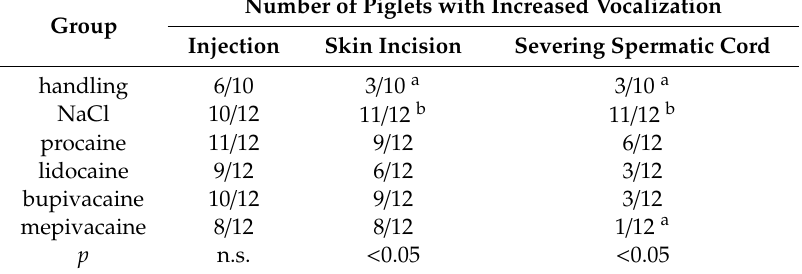
Table 3. Number of piglets with increased vocalization / number of piglets per group during injection, skin incision and severing spermatic cord.